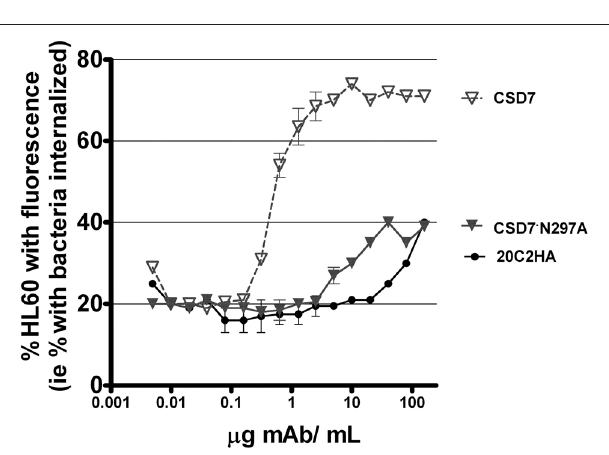
FIGURE 4 | OP activity mediated by mAbs CS-D7, CS-D7 · N297A, or isotype control 20C2HA. OP activity was measured by combining differentiated HL60 with fluorescently labeled opsonized S. aureus , incubating the mixture, and measuring HL60 with engulfed bacteria, as described in the Methods section. Data shown are the mean ± s.e. n =